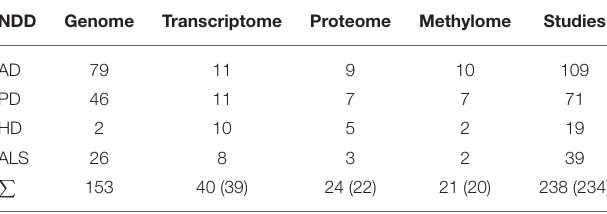
TABLE 1 | A summary of the number of used studies per disease and